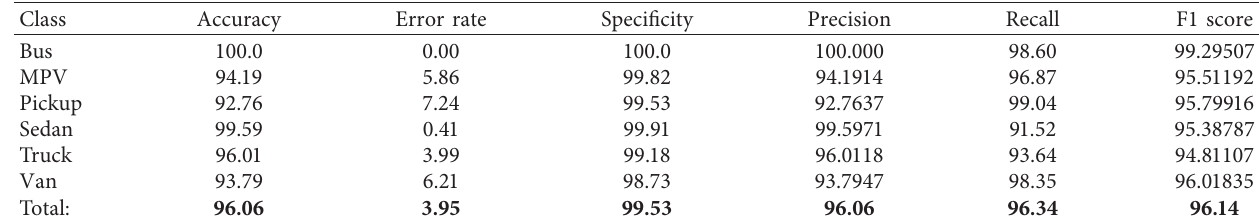
Table 5: Performance matrices of modified CNN on VeRi dataset.